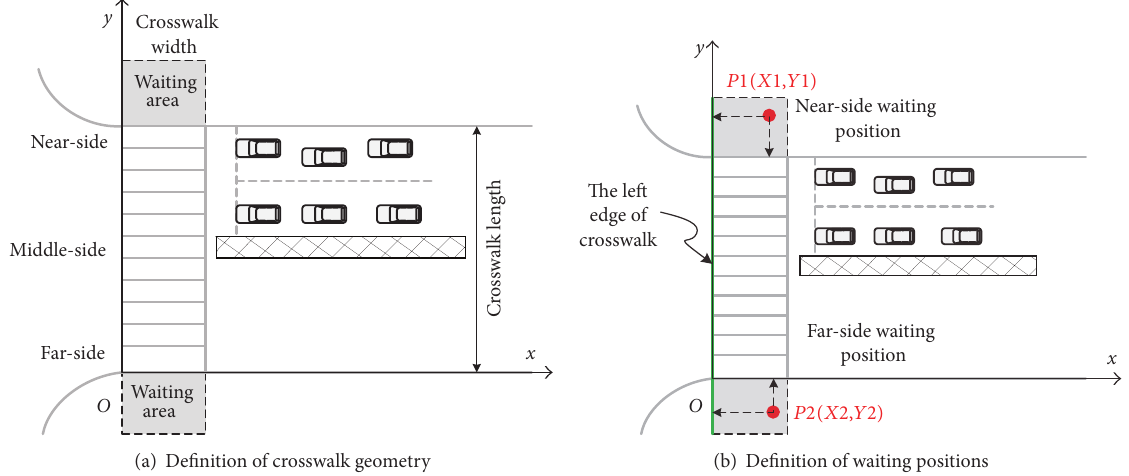
Figure 1: Definition of